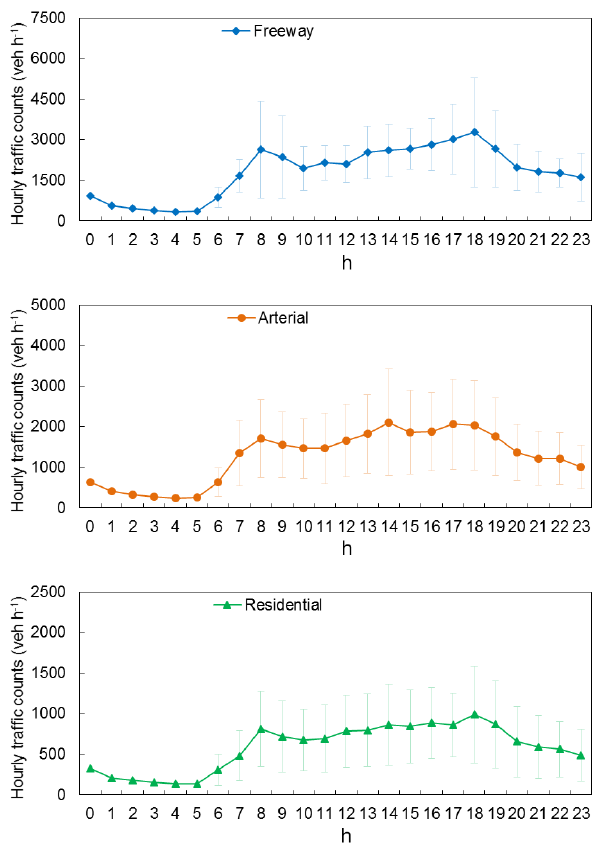
Figure 2. Mean hourly traffic accounts of observed links by road class during weekdays in 2010. The error bars indicate standard de- viations of observed data from 06:00 to